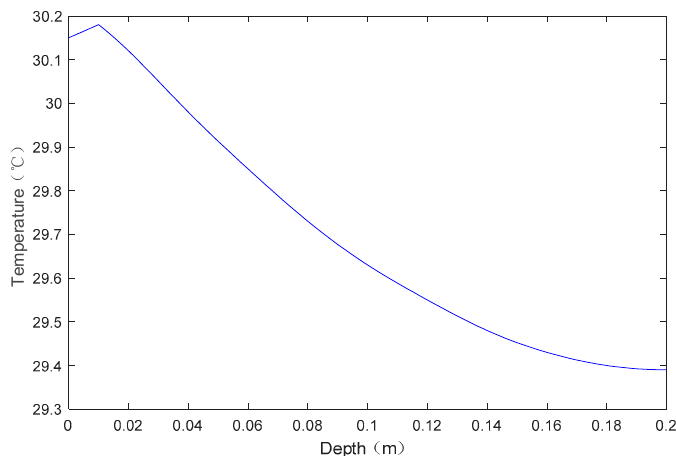
Figure 7. Temperature calculated for the asphalt pavement at 12:00 p.m.